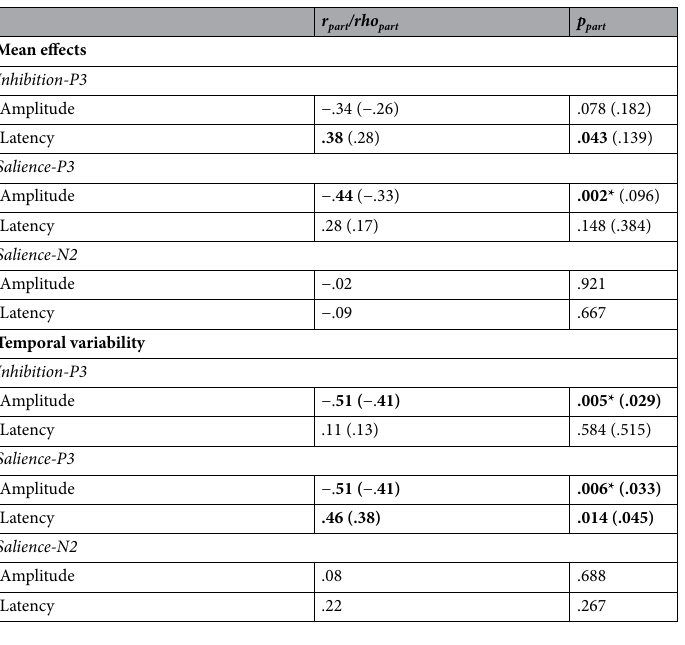
Table 2. ADHD Index and neuronal markers of inhibition and salience processing measured at POz (and Pz) for inhibition and salience effects in P3 and at Fz for salience effects in N2. Significant associations ( p < .05) are depicted in bold letters. Associations passing the Bonferroni corrected-threshold of p = .0125 (four comparisons) are marked with an asterisk. r part , Pearson’s correlation coefficient for the partial correlation controlling for effects of age, sex, and SPM raw scores; rho part , Spearman’s rank order correlation coefficient for the partial correlation controlling for effects of age, sex, and SPM raw scores (used when data violates significantly the assumption of normality. This refers to six associations: Between ADHD Index and mean effects in Salience-P3 amplitude at POz and Pz, between ADHD Index and mean effects in Salience-N2 amplitude at Fz, between ADHD Index and temporal variability in Salience-P3 amplitude at POz and Pz, and between ADHD Index and temporal variability in Salience-N2 amplitude), p part , p value of significance for the partial